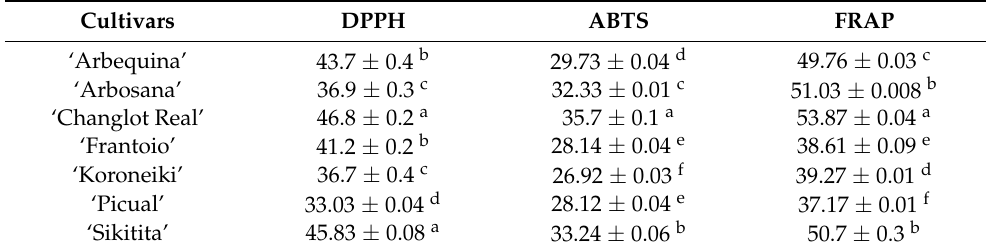
Table 5. Antioxidant activity of olive leaf cultivars at optimum sonotrode ultrasound-assisted extraction. Different letters in the same column indicate significantly different values ( p <